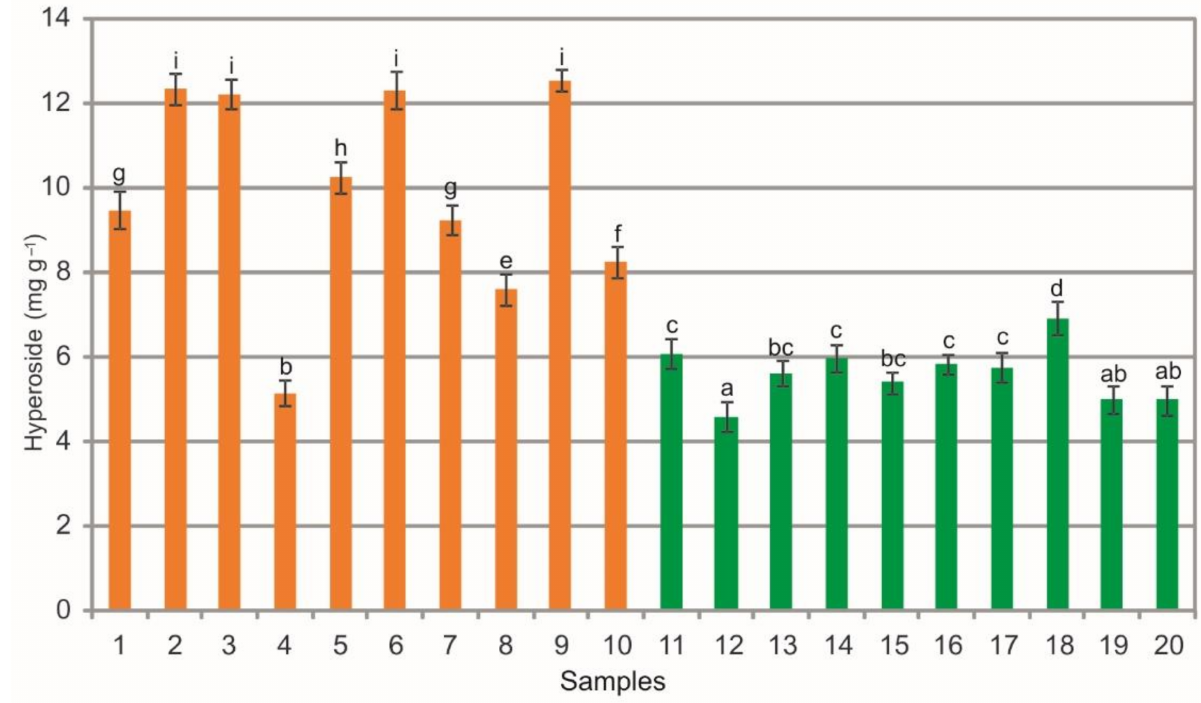
Figure 6. Hyperoside contents (mg g − 1 ) in leaf extracts from bearberry plants collected in heathland populations (orange) and in pine forest populations (green). For each site, data are mean and SD. The values designated by the different letters are significantly different (Tukey test, p <